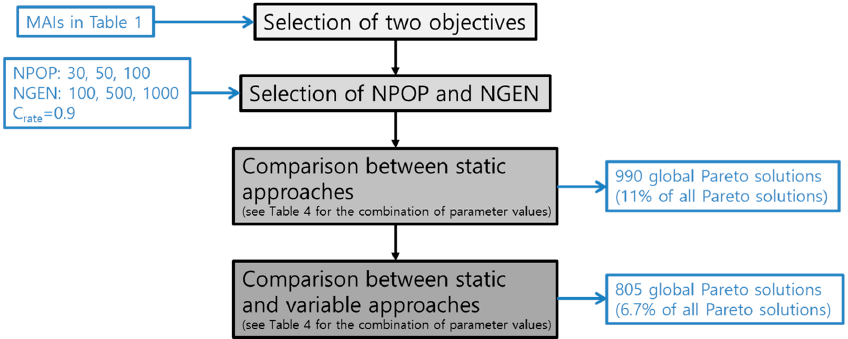
Figure 5. Flow chart of the application results section.